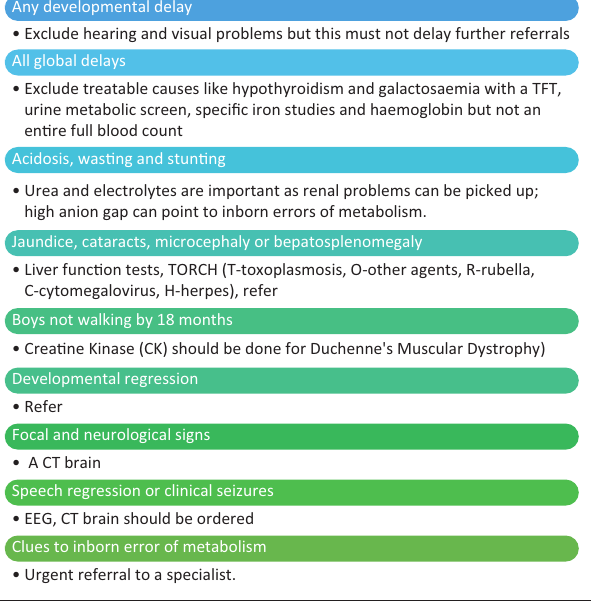
FIGURE 2: Considerations in the diagnostic